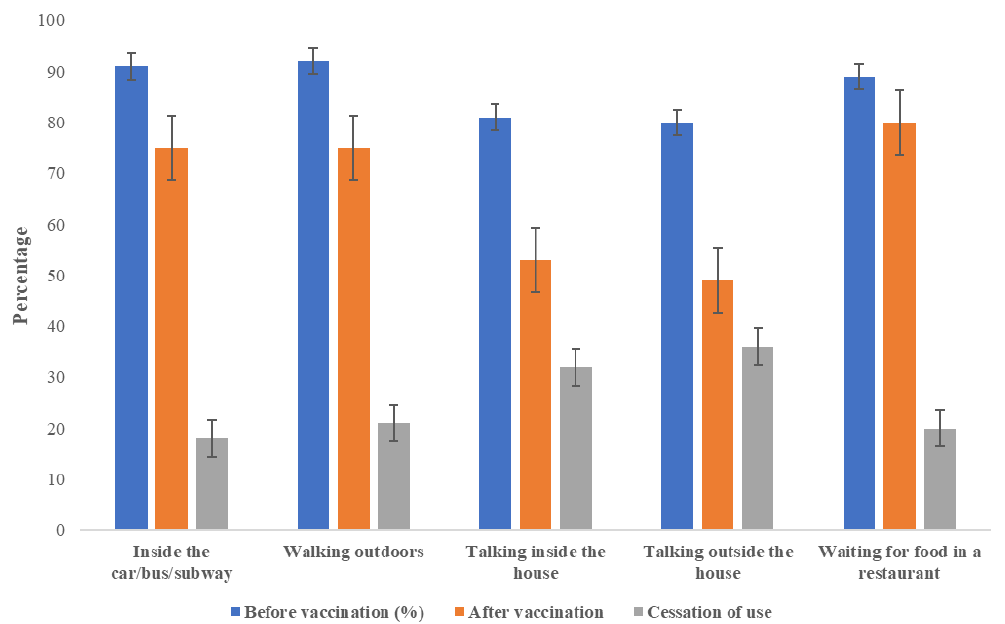
cessation of face mask use at the univariate level. Only two factors were related at the multivariate level, discontinuation of feeling vulnerable for hospitalization increased the odds of non-use after vaccination (adjusted OR = 3.3, 95% CI 1.2, 8.6), and the perception of